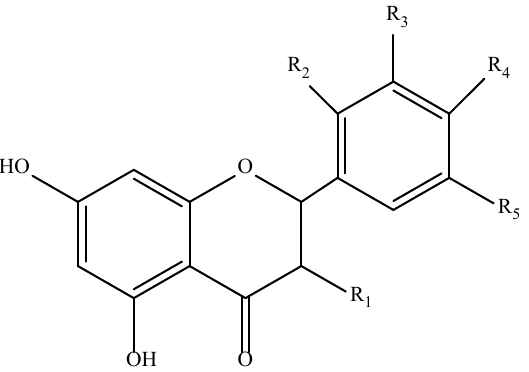
Figure 6. Most common structure of flavonoids. R1-R5 can range from hydrogen atoms to hydroxyl or methoxy groups [46].